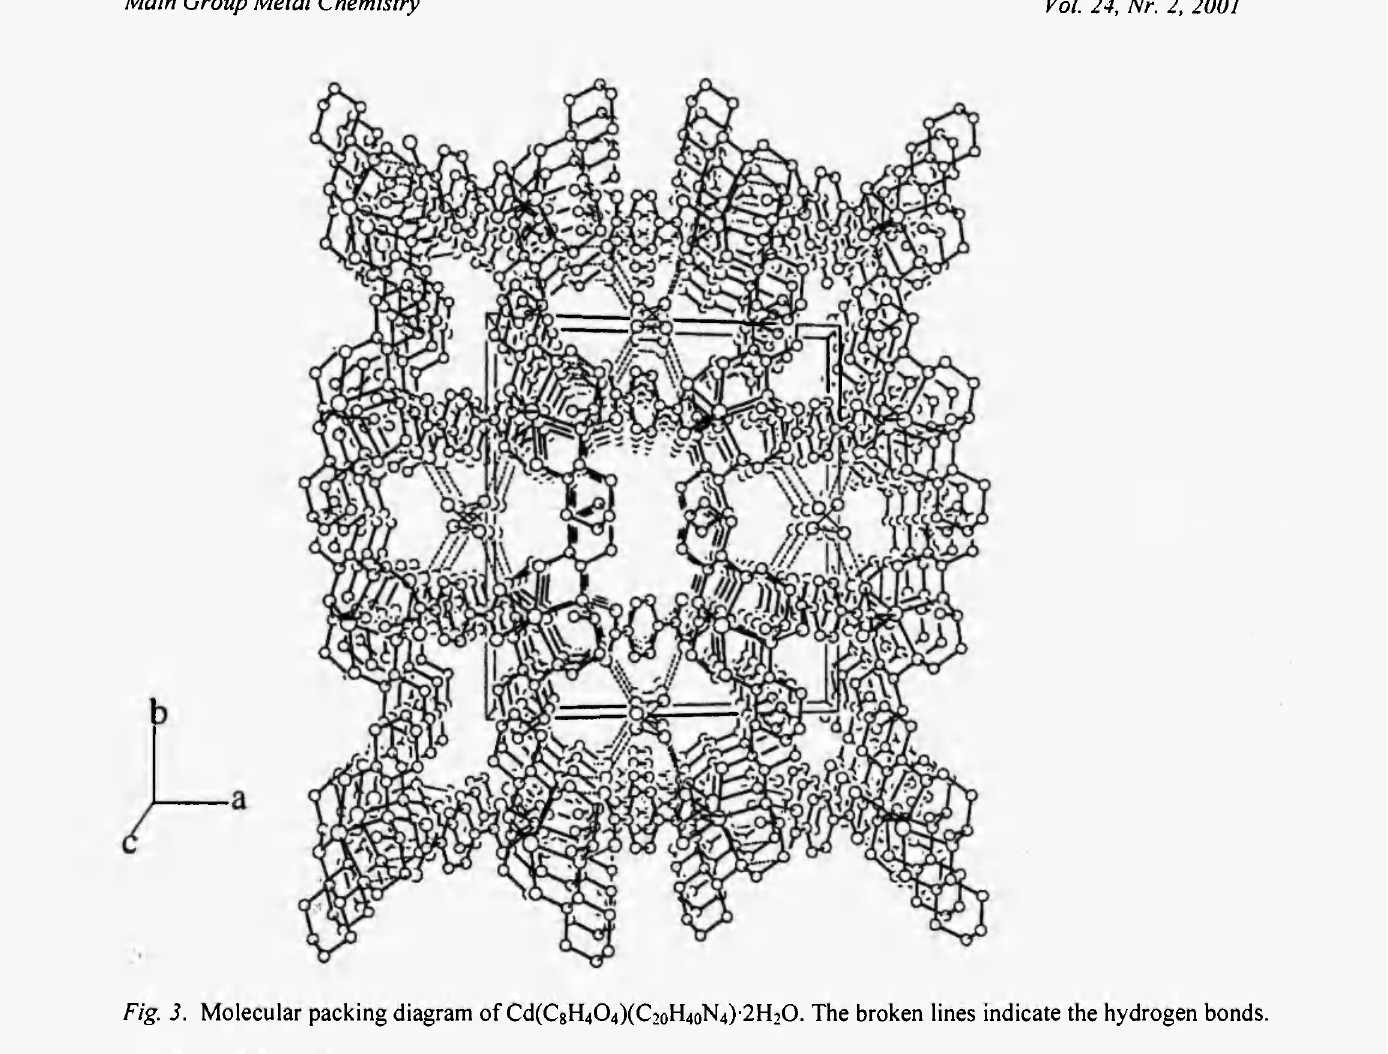
Fig. 3. Molecular packing diagram of Cd(C 8 H 4 04)(C2oH4oN4)-2H20. The broken lines indicate the hydrogen